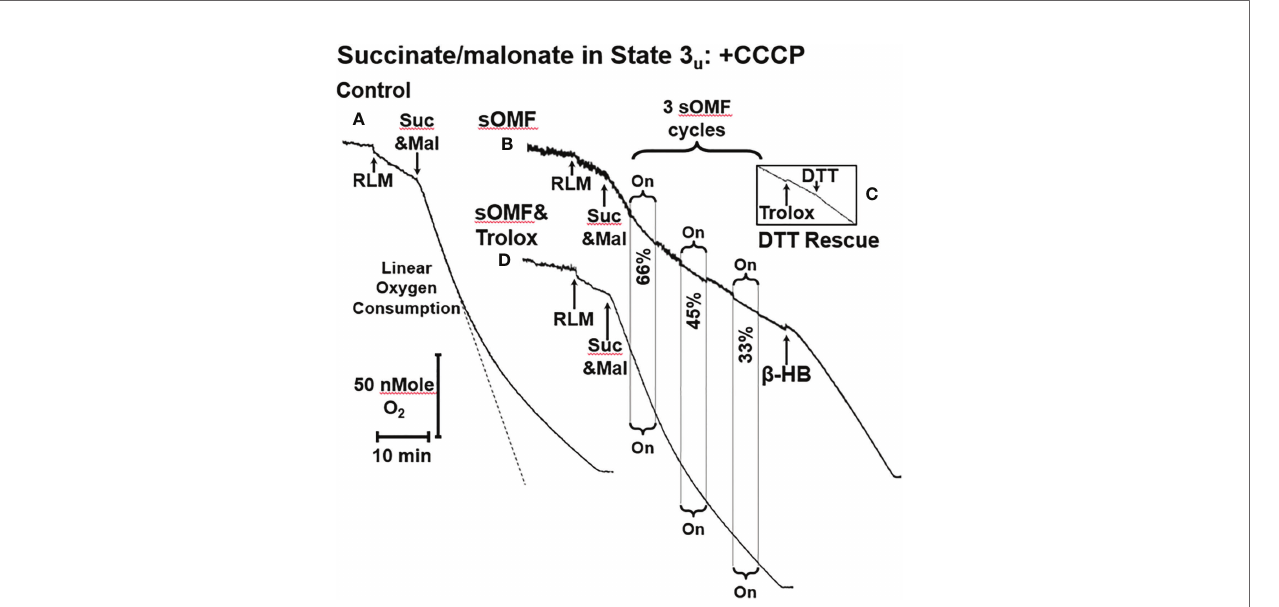
FIGURE 2 | sOMF inhibits SDH in State 3 u RLM. (A) An O 2 electrode trace showing the consumption of O 2 by RLM oxidizing 10 mM succinate in the presence of 500 m M malonate and 2 m M CCCP, State 3 u . (B) sOMF stimulation of under the same conditions causes inhibition of succinate oxidation that continues after halting of fi eld rotation. Addition of b -HB (10 mM) restores mitochondrial respiration showing that the mitochondria have competent complexes I, III and IV. (C) An insert of an O 2 electrode trace from in a parallel experiment to (B) , but instead of b -HB, the antioxidant Trolox (15 m M) and DTT (10 mM) was added. Trolox was not able to restore activity to sOMF-treated RLM oxidizing succinate, but DTT can partly restore respiration. (D) Pretreatment of RLM with the antioxidant Trolox (15 m M) prior to sOMF treatment can halt the inhibition of succinate